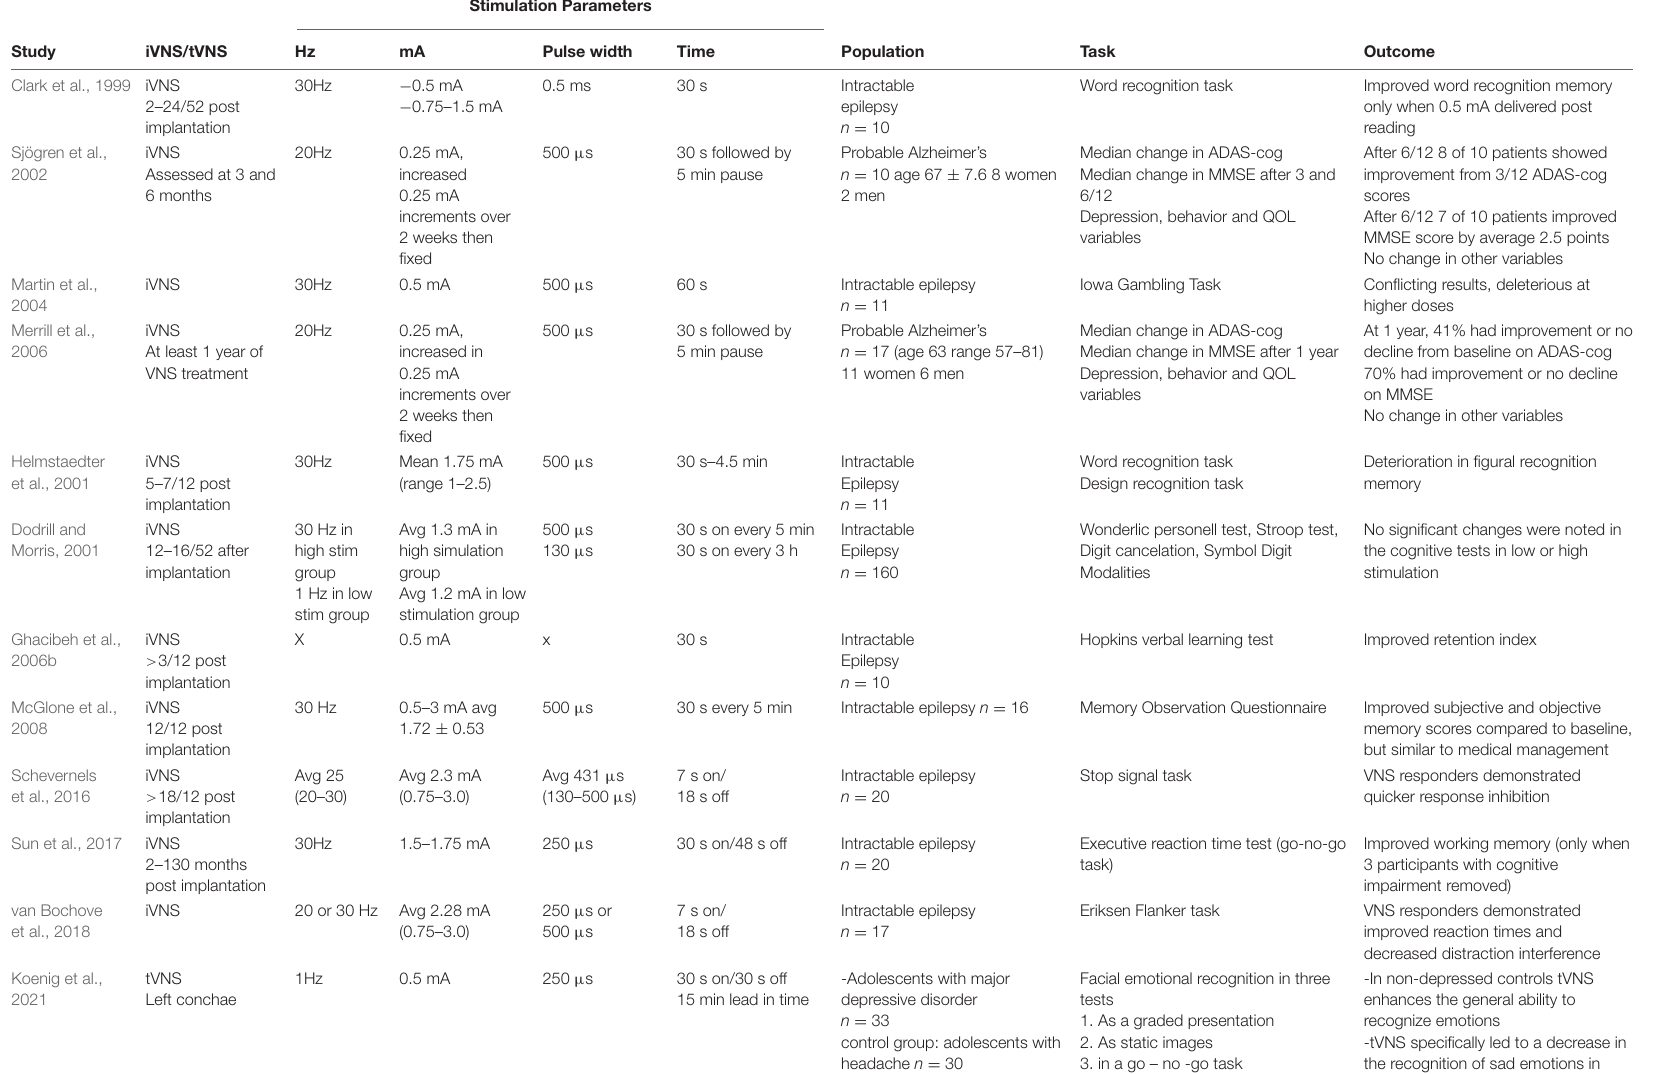
TABLE 3 | VNS and cognition in clinical